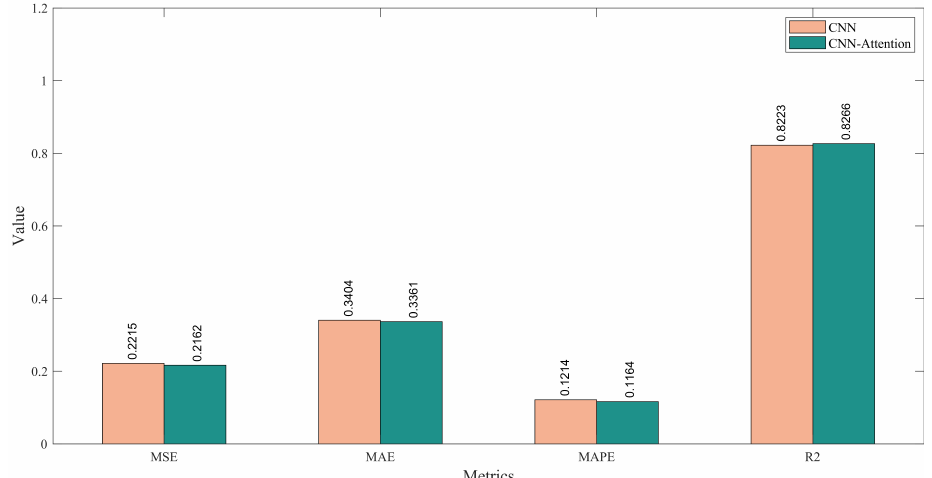
Figure 15. CNN-Attention and CNN performance